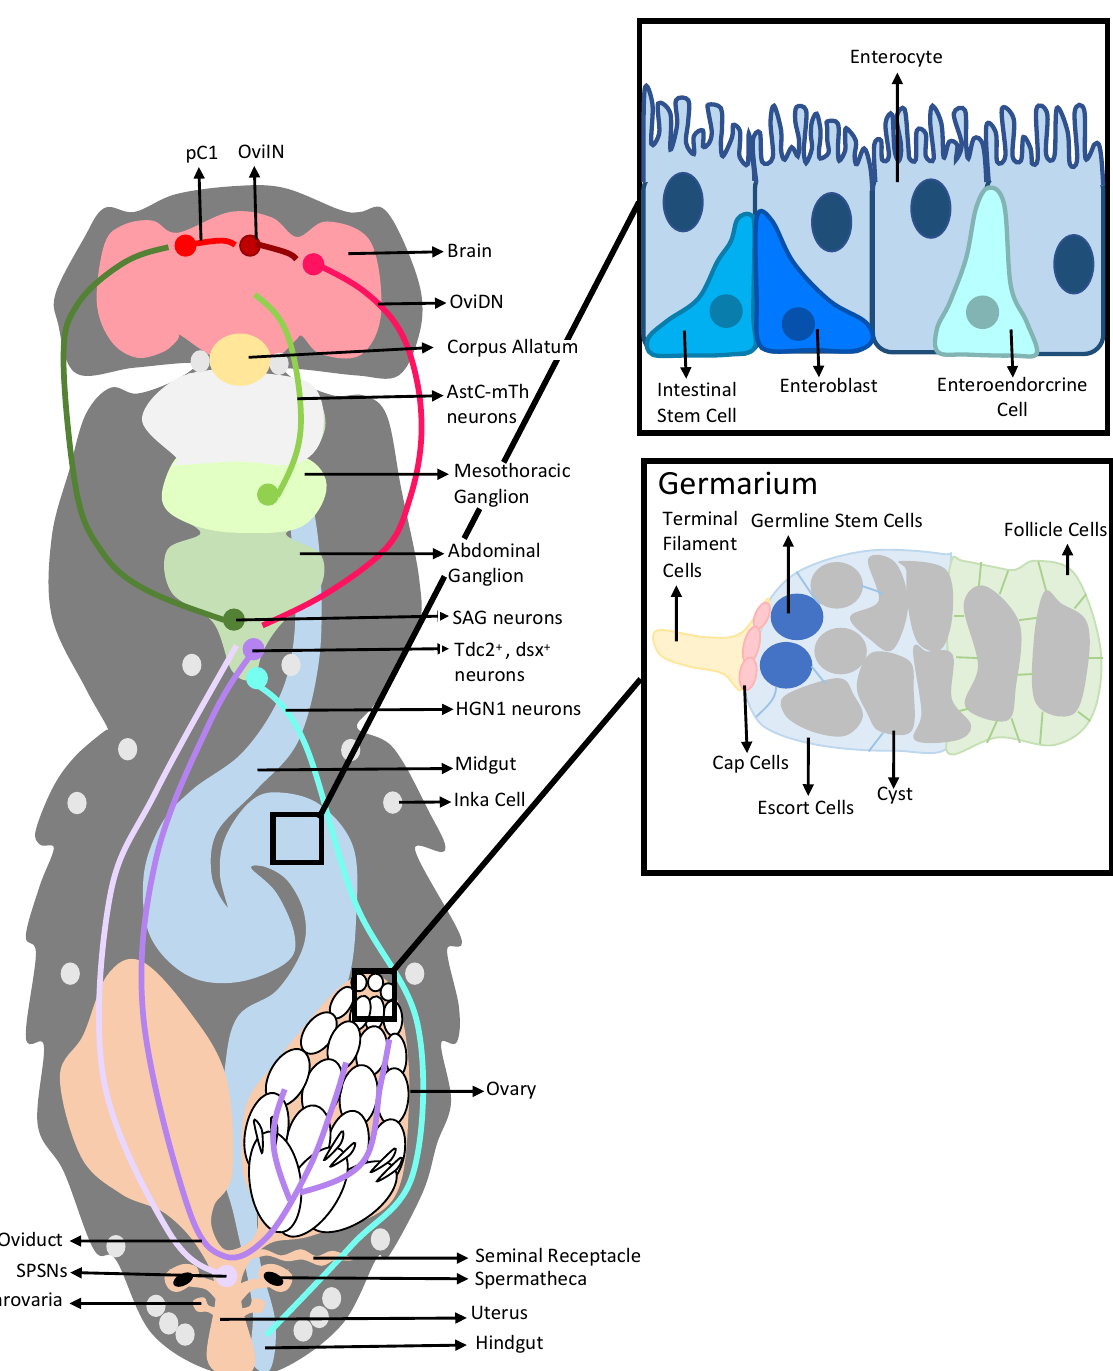
Figure 1. Anatomical diagram of the organs and cell types of Drosophila melanogaster females that are involved in post-mating responses triggered by seminal proteins in the reproductive, digestive and nervous systems (not to scale). Figure elements are adapted from [33–35].